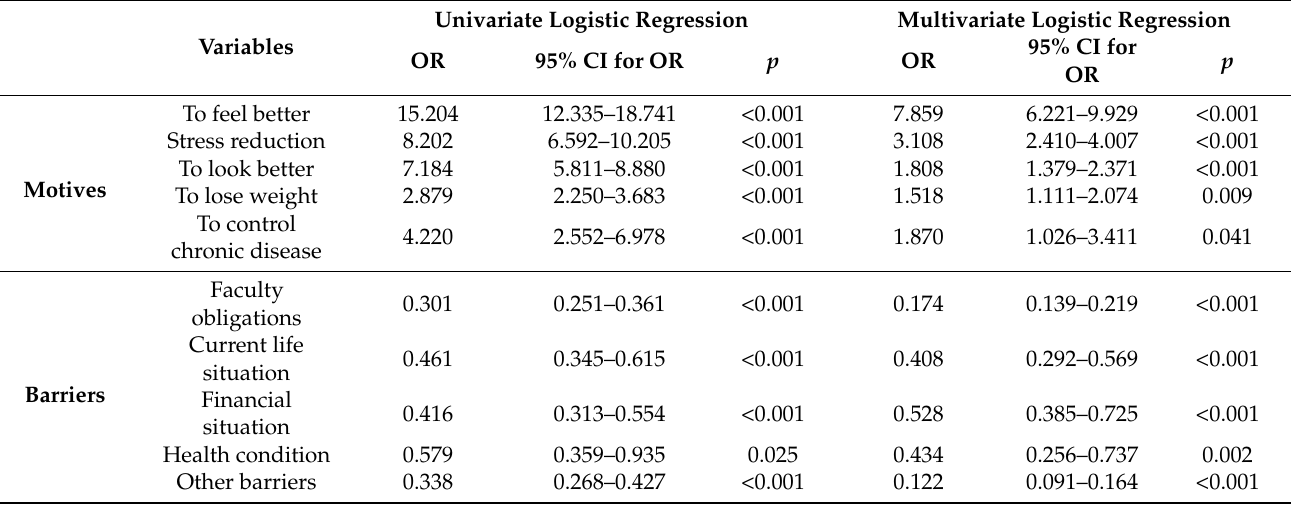
Table 8. Association between the independent variables (motives and barriers for regular physical activity) and engagement in regular physical activity among medical students.